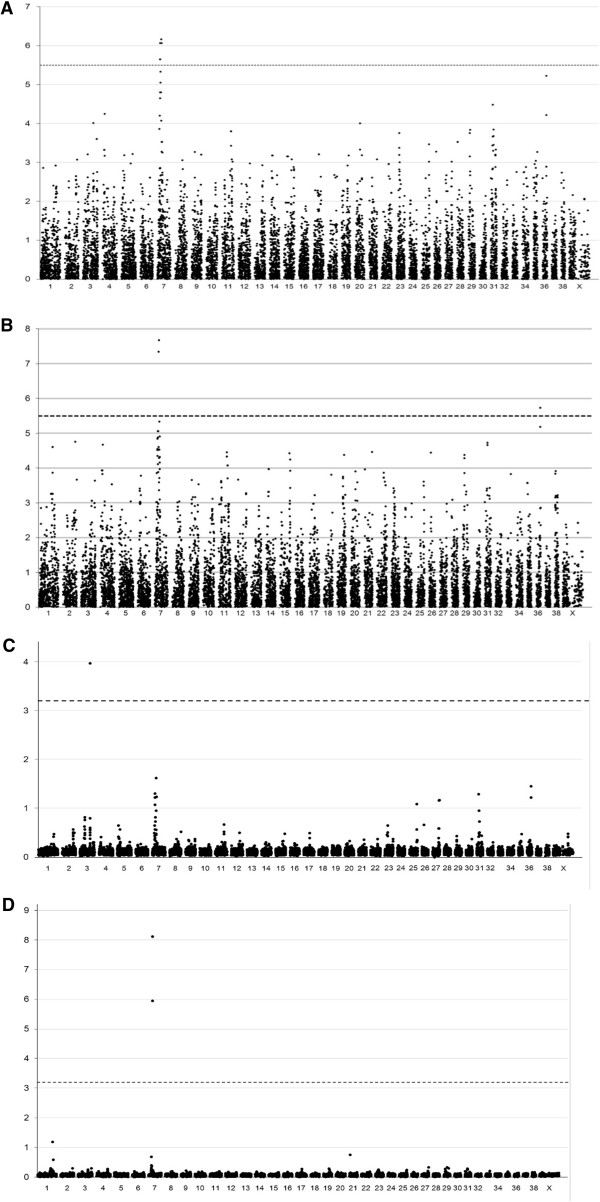
Genome-wide association analysis of patellar luxation in Flat-Coated Retrievers. (A) Association of individual SNPs with patellar luxation was analyzed with PLINK software by comparing allele frequencies in the cases (n = 45) and controls (n = 40). (B) Association analysis of individual SNPs using the Estimated Breeding Values (EBV) as phenotype using PLINK. (C) Multi-SNP association analysis was performed using the case/control patellar luxation status and iBAY software. (D) same as (C) using EBV as phenotype. The –10log of the P-values obtained of individual SNPs are plotted in (A) and (B), with the dotted lines indicating the Bonferroni threshold over 15,823 SNPs (α = 0.05). Multi-SNP association values are presented as Bayes factors in (C) and (D), with the dotted lines indicating the ‘substantial’ effect threshold according to guidelines by Kass and Raftery [19].